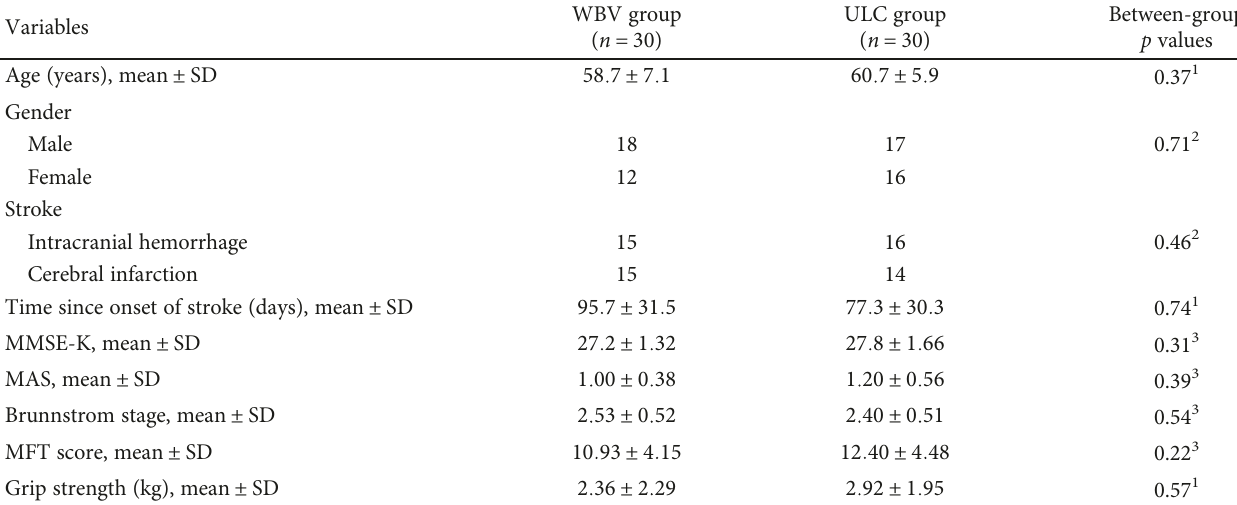
Table 1: Characteristics of participants.